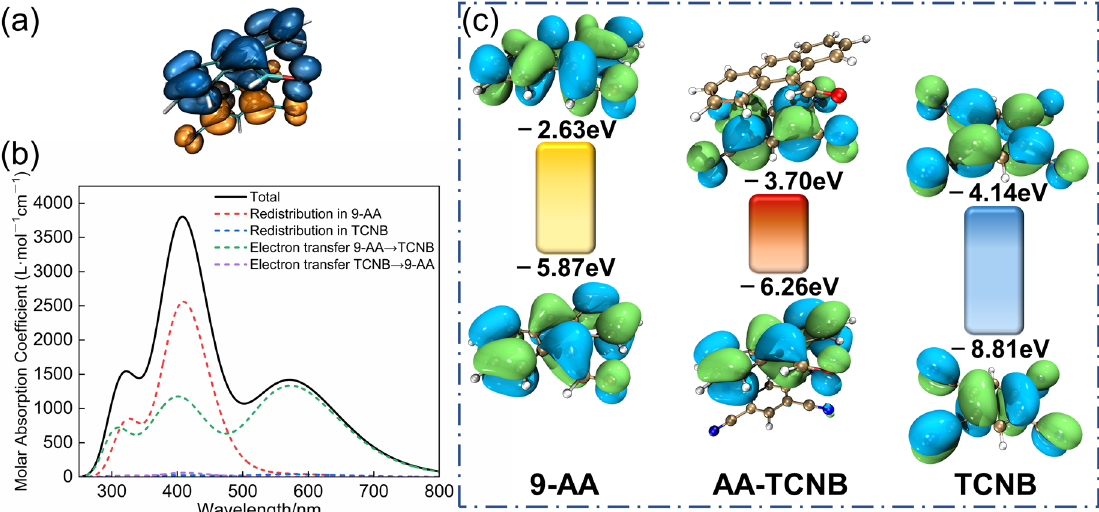
Figure 5. ( a ) The distribution of holes and electrons in the excited state S 1 of AA-TCNB. ( b ) Calcu- lated charge transfer spectra of AA-TCNB. ( c ) Molecular orbital energy levels of AA-TCNB and its monomers (bo tt om: HOMO; top: LUMO).